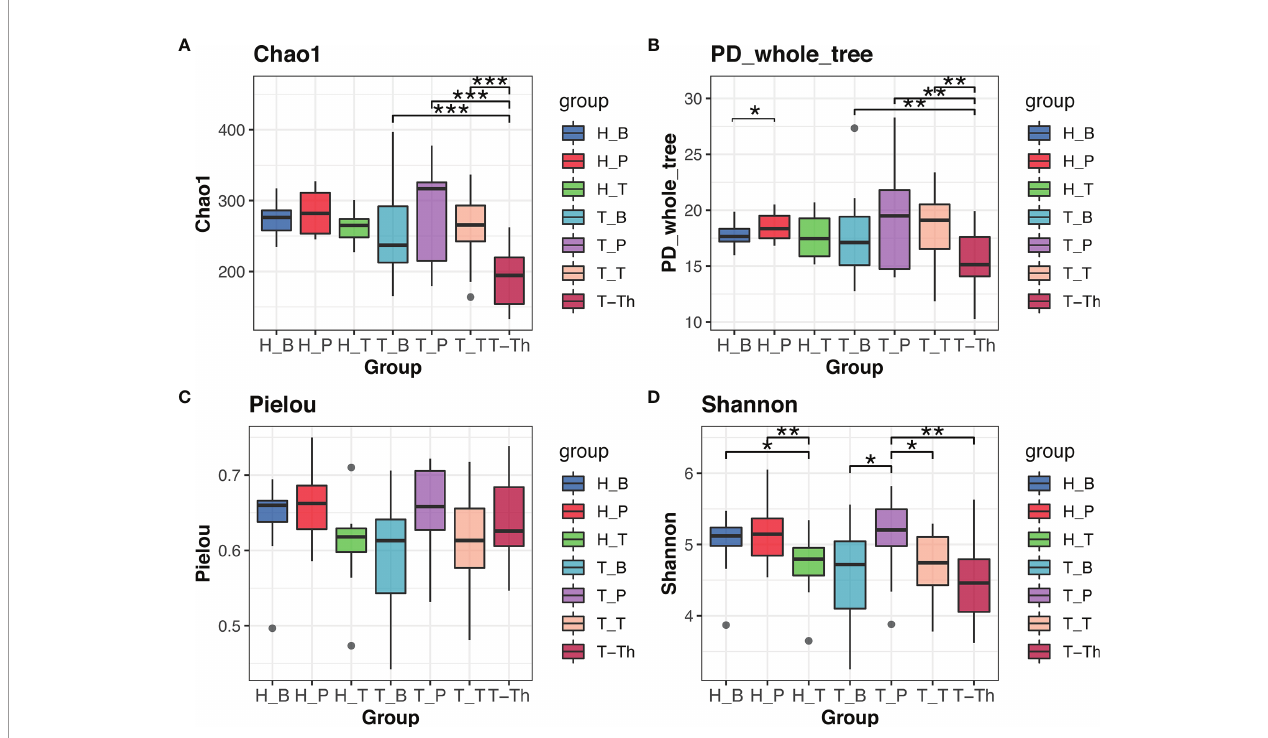
FIGURE 1 | Alpha diversity comparison in Chao1 (A) , PD_whole_tree (B) , Pielou (C), and Shannon (D) indexes within all the subgroups. * p < 0.05, ** p < 0.01, *** p <